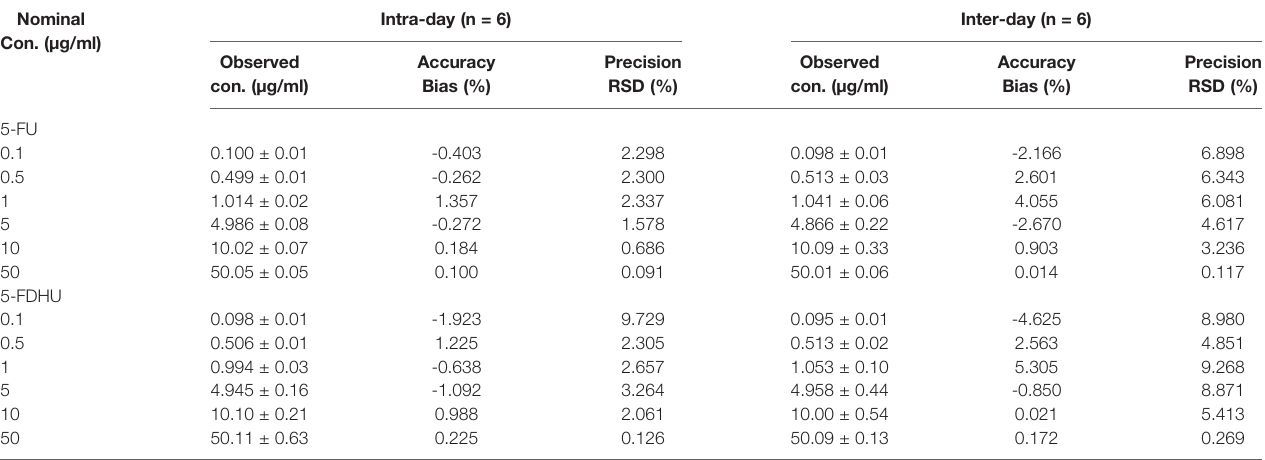
TABLE 4 | Inter-day and intra-day assay precision (% RSD) and accuracy (% Bias) values for the HPLC-UV method for the determination of 5-FU and 5-FDHU in rat bile. Nominal Con.